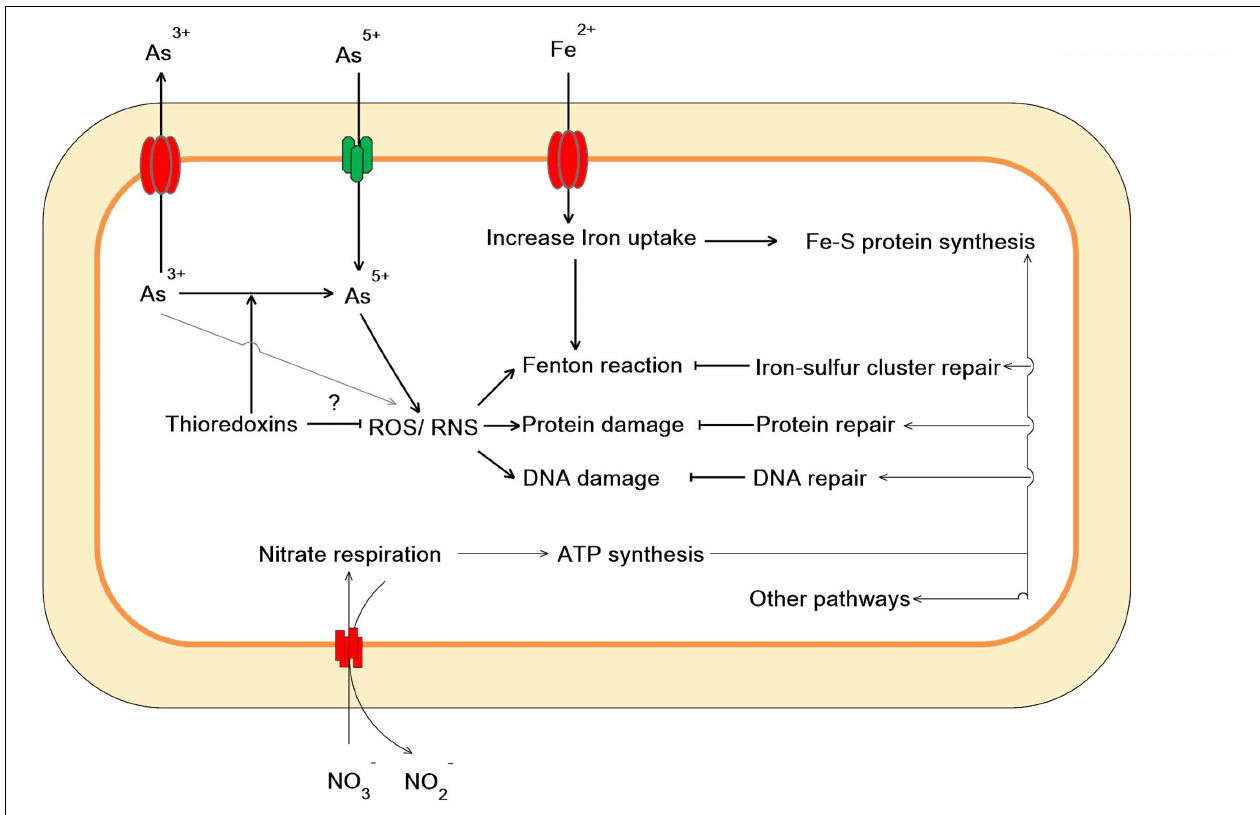
FIGURE 6 | Proposed scheme illustrating cellular events related to As(V) stress in